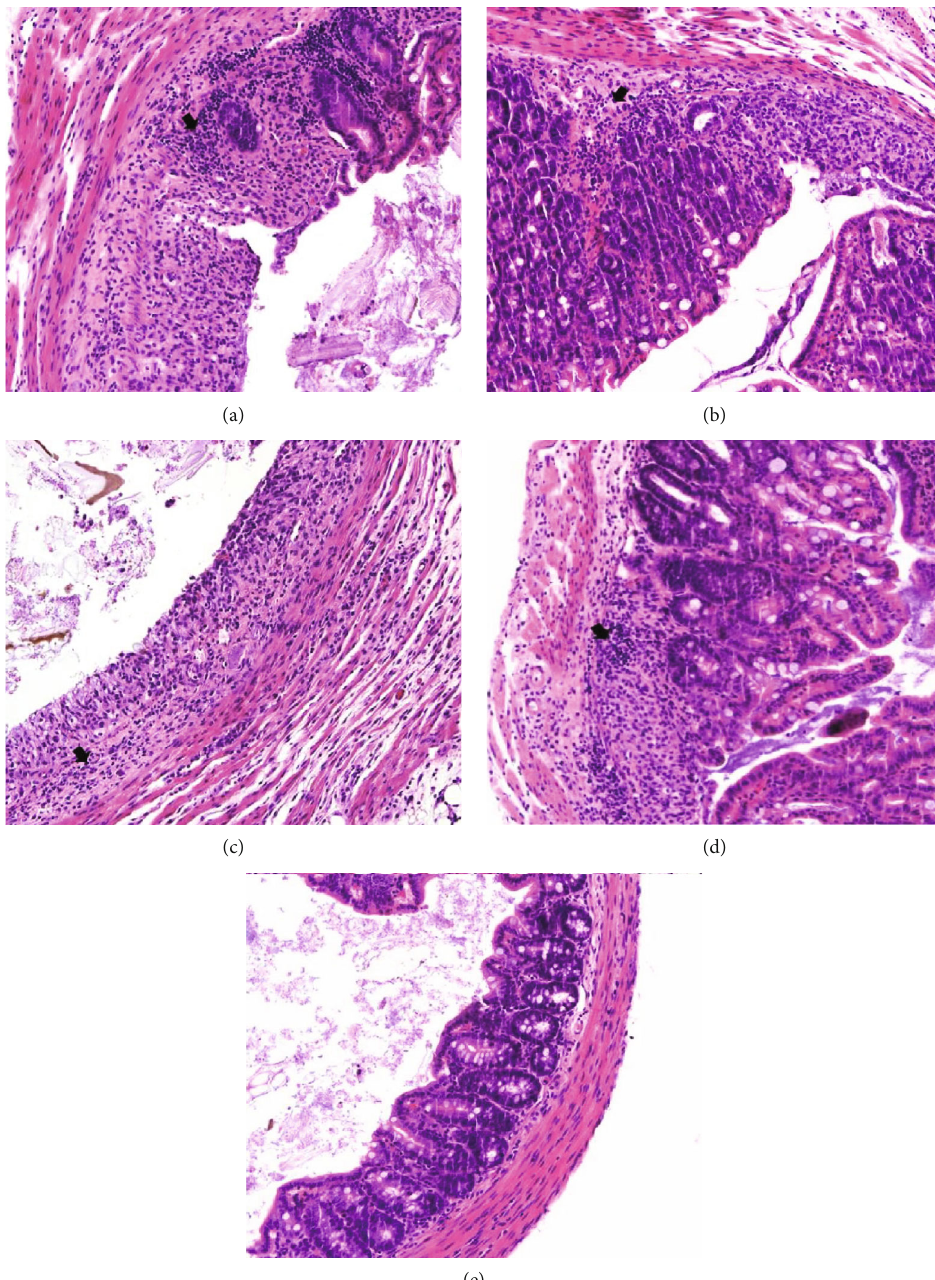
Figure 4: Histopathological features of jejunum of the IBD group of mice treated with PBS (a; IBD-PBS-positive group), probiotics (b; IBD- Pro), synbiotics (c; IBD-Syn), peptide 1 (d; IBD-Pep 1), and peptide 2 (e; IBD-Pep 2). Hematoxylin and eosin- (H&E-) stained sections of a mouse large intestine are shown. Black arrows indicate in fl ammation of the colitis mucosa. Magni fi cations: ×